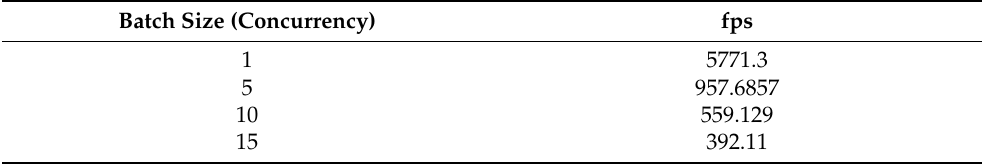
Table 2. The tracking speed with different batch size of bounding box.